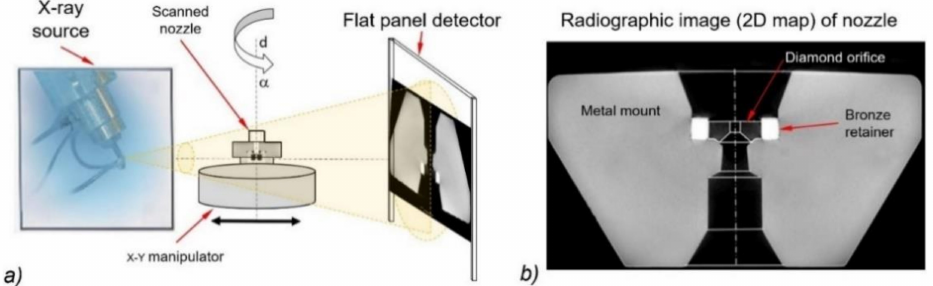
Figure 2. X-ray CT scheme: ( a ) projection of the water nozzle using the CT method; ( b ) 2D image of the water nozzle.